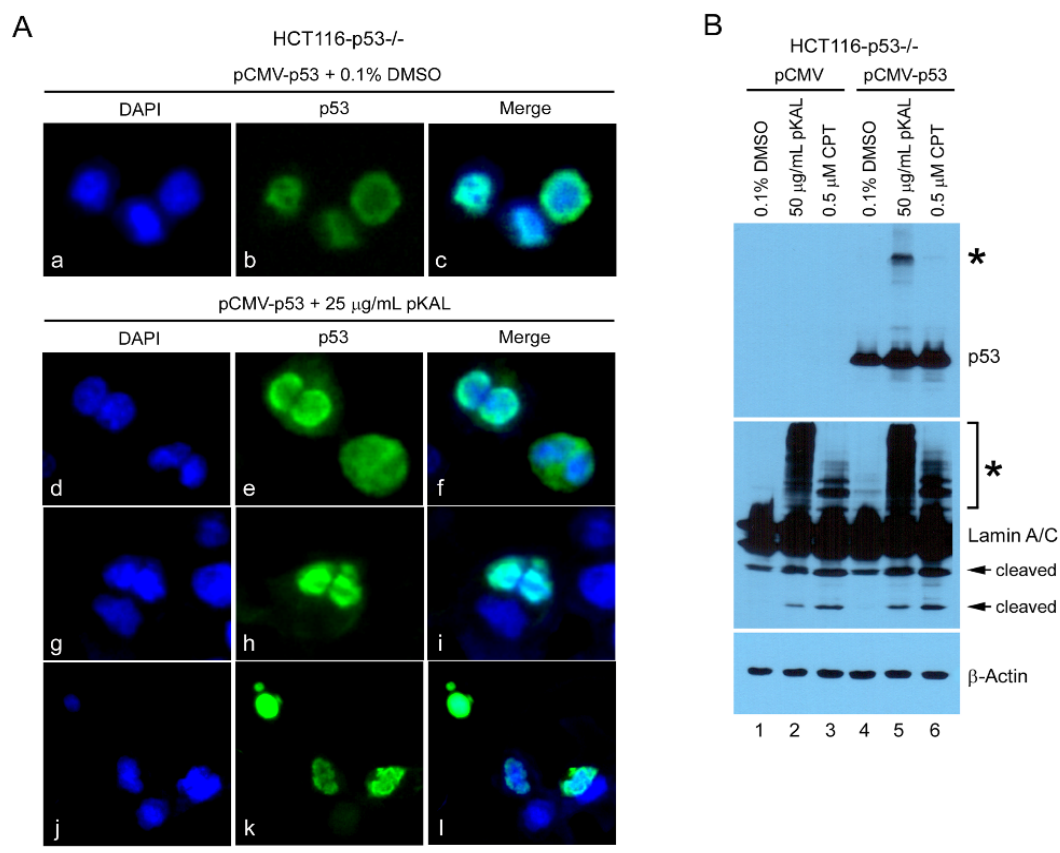
Figure 5. Effect of ectopic p53 upregulated by pKAL in nuclear structure change and post-translational modification of lamin A/C in p53-null HCT116 cells. ( A ) HCT116-p53 − / − cells were transfected with 1 µg pCMV-p53 and then treated with 0.1% DMSO or 25 µg/mL pKAL for 48 h. Cells were analyzed by immunofluorescence microscopy; DAPI (blue), p53 (green), and Merge (DAPI and p53). ( B ) HCT116-p53 − / − cells were transfected with 2 µg of pCMV or pCMV-p53 plasmid DNA and then treated with 0.1% DMSO, 50 µg/mL pKAL or 0.5 µM CPT for 24 h. Cells were analyzed by Western blot using p53, lamin A/C and β -actin antibodies. The asterisks indicate the higher molecular weight post-translational modified forms of p53 and lamin A/C, respectively, whereas the arrows indicate the lower molecular weight cleaved forms of lamin A/C.